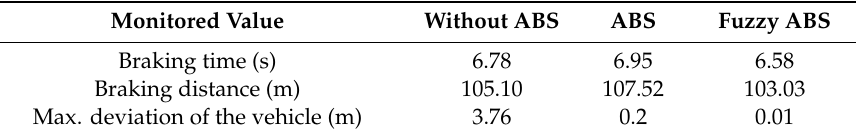
Figure 15. Maneuverability test on dry road at speed 100 km / h—( a ) Speed curve; ( b ) Braking distance; ( c ) Vehicle trajectory. Table 7. Maneuverability test on dry road at speed 100 km / h.